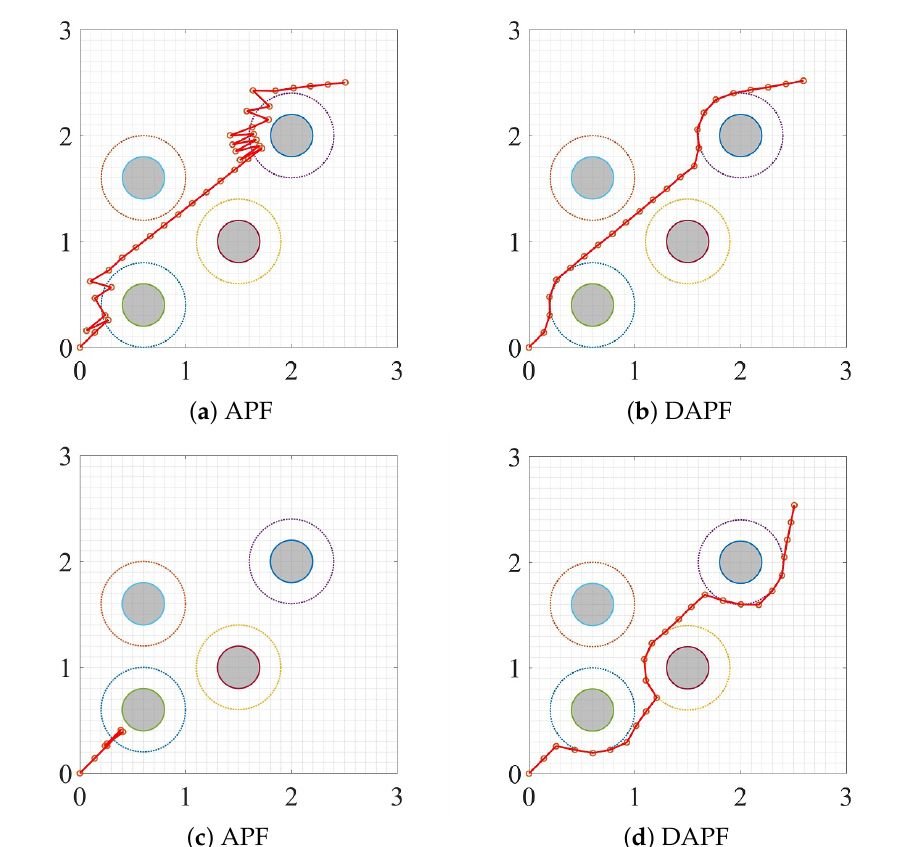
Figure 6. Experimental results using APF ( a , c ) and proposed DAPF ( b , d ) in the static environment where the gray solid circles are obstacles, the circles that around obstacles means the influence range, the small green circle is the robot position, and the red curve is the planned path. The APF has the oscillation problem that occurs in the ( a ) and local minimum problem that occurs in the ( c ), whereas the DAPF solves such problems and achieves better results as shown in ( b , d ), respectively.